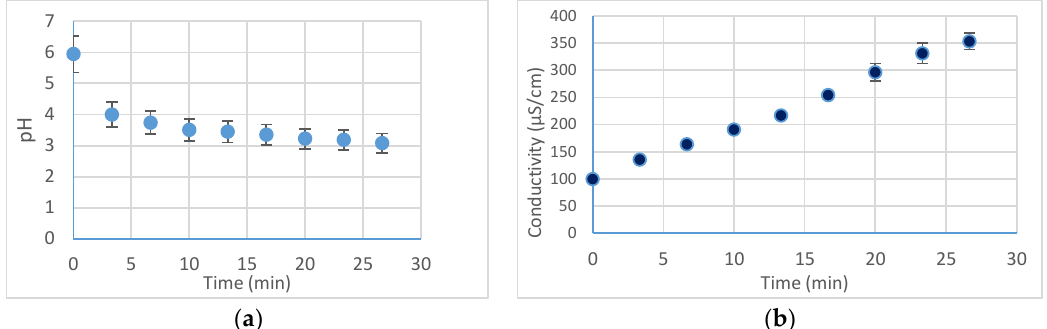
Figure 7. Variation of pH ( a ) and conductivity ( b ) of the discharge solution with time at 21.6 kV voltage amplitude.